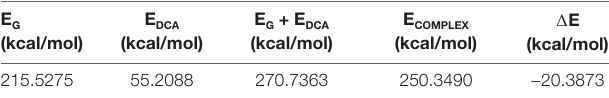
TABLE 1 | The minimized total energies of gliclazide, DCA and their complex.